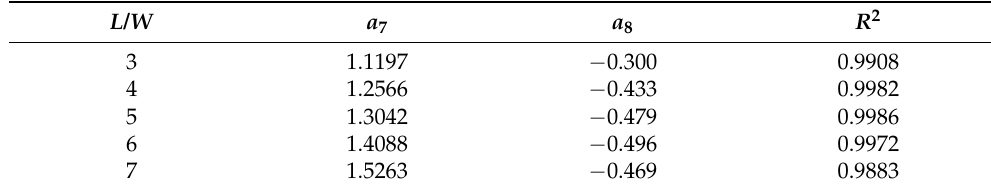
Table 2. Values of coefficients a and b for different L / W ratios.